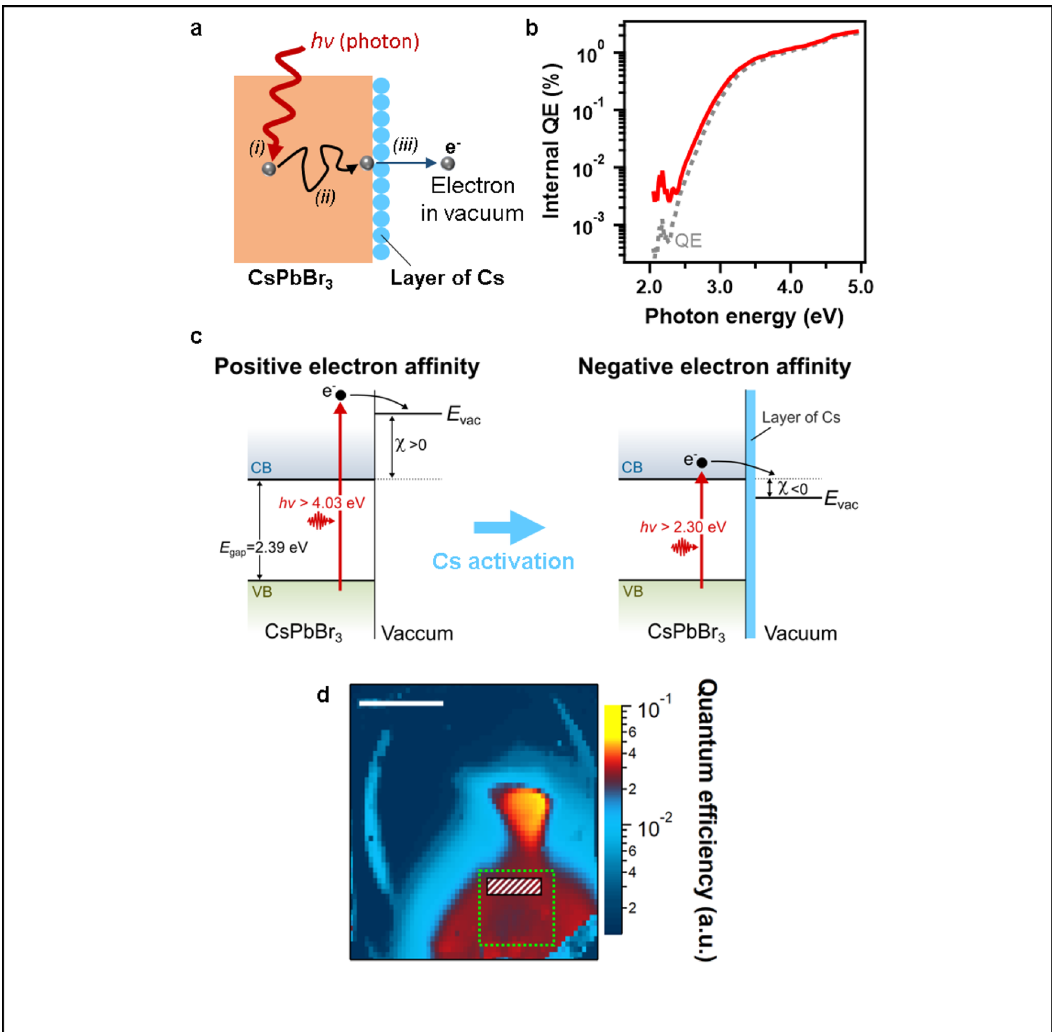
Fig. 3 Physical origin of the ef fi ciency of the photoelectric effect. a Mechanism of the photoelectric effect showing the three main steps: (i) electron photogeneration, (ii) electron transport, and (iii) electron emission. b Internal quantum ef fi ciency of the photoelectric effect in the CsPbBr3 thin fi lm after Cs activation. The gray dashed curve shows the corresponding (external) quantum ef fi ciency, copied from Fig. 2a. c Schematics of the band diagram at the CsPbBr3 thin fi lm surface before and after Cs activation. Egap, VB, CB, χ stand for the bandgap, the valence band, the conduction band, and electron af fi nity. Evac indicates the vacuum level where the electron can be emitted from the surface after photoexcitation (h ν ). d Spatial map of the quantum ef fi ciency relative to its maximum value for the CsPbBr3 thin fi lm after Cs activation. Scale bar is 10 mm. Dashed area mark the position of the in-situ Cs source. The quantum ef fi ciency exhibits peak values near the center of the sample in a 10 mm 2 area, while other regions of the samples yield slightly smaller but uniform ef fi ciency within 10% margin variations over a 1 cm 2 (indicated by dashed-green-square